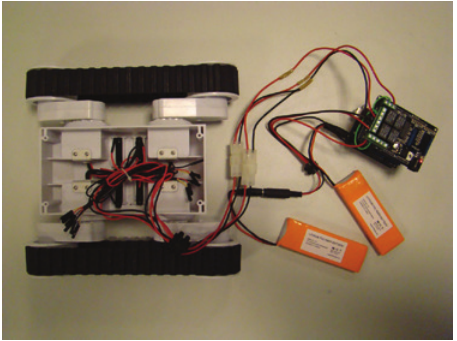
Figure 1: Components of the Web-Controlled Home Robot.